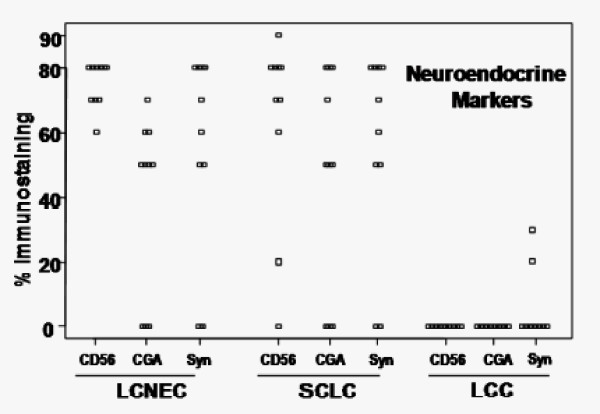
Immunohistochemistry with antibodies raised against established neuroendocrine markers, CD56, CGA, and Syn.